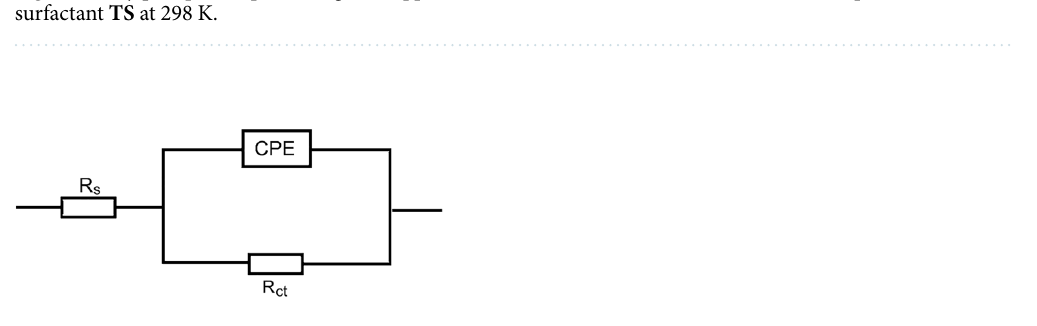
Figure 9. Electrochemical equivalent circuit to optimize the EIS output data for the copper corrosion in 1.0 M H 2 SO 4 solution and in the presence of the examined surfactants.